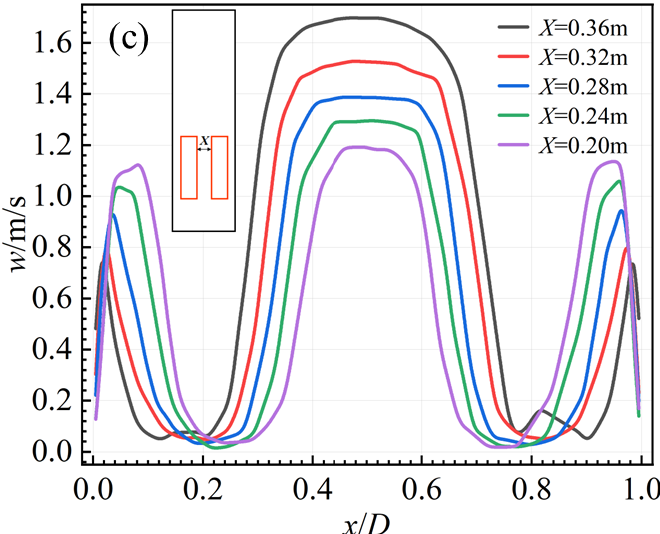
Figure 4. Temperature and velocity distributions of specific cross sections with different X and z at L = 0 m. ( a ) Local surface temperature distribution of vertical lines on the heat source surfaces. ( b ) Vertical velocity distribution at different positions in the channel which X = 0.36 m ( c ) Vertical velocity distribution with different horizontal distance X in the channel which z = 0.45 m.